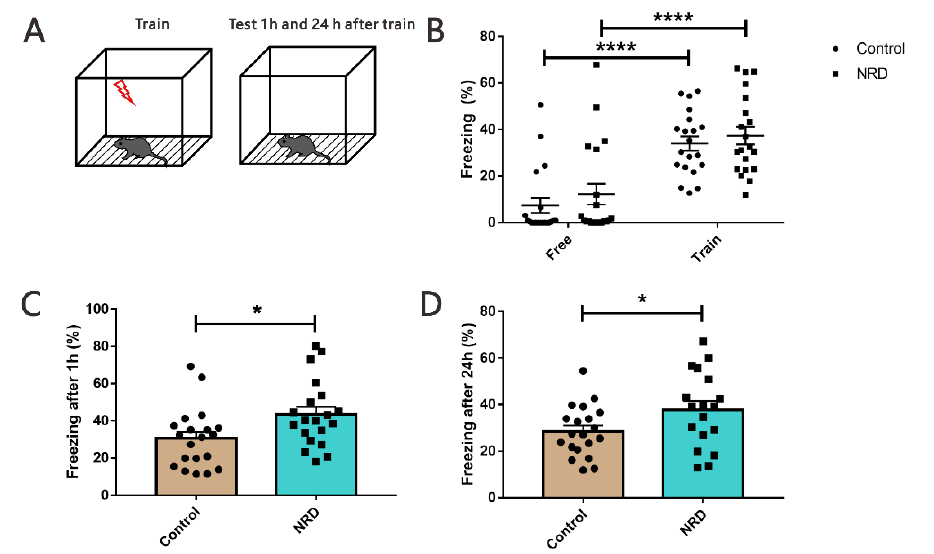
Figure 7. Enhanced contextual fear memory in NRD mice. ( A ) Diagram of the contextual fear conditioning test. ( B ) Performance of control mice and NRD mice before and during training. **** p < 0.0001 as determined by the two-way ANOVA. n (control) = 20, n (NRD) = 20. ( C ) Freezing behavior tests after 1 h of training. n (control) = 20, n (NRD) = 20. ( D ) Freezing behavior tests after 24 h of training. n (control) = 20, n (NRD) = 18. * p < 0.05 as determined by the unpaired Student’s t -test. Data are expressed as the means ± SEMs.